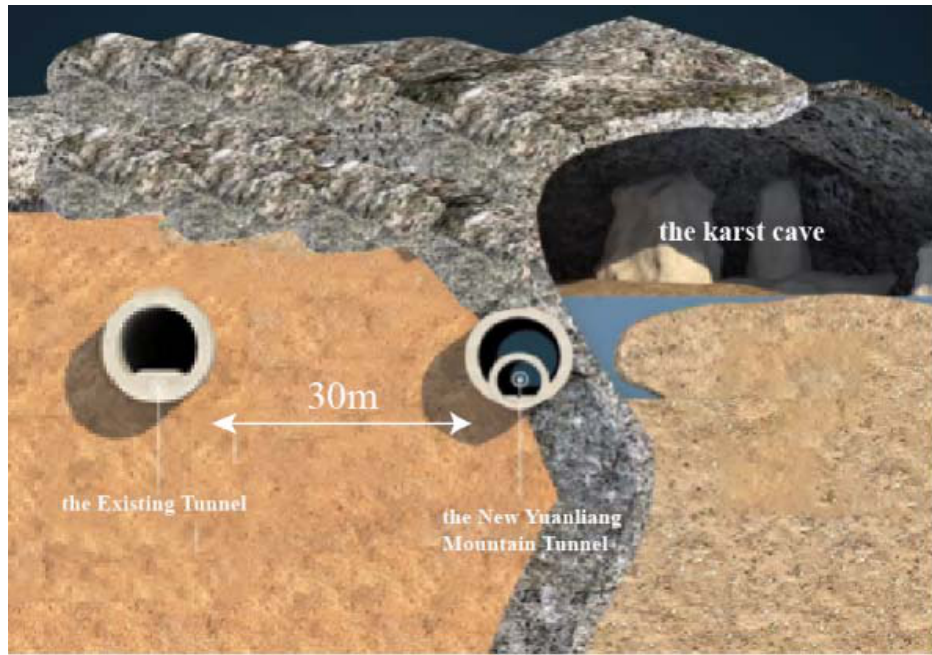
Figure 18. The New Yuanliang Mountain Tunnel geological profile.